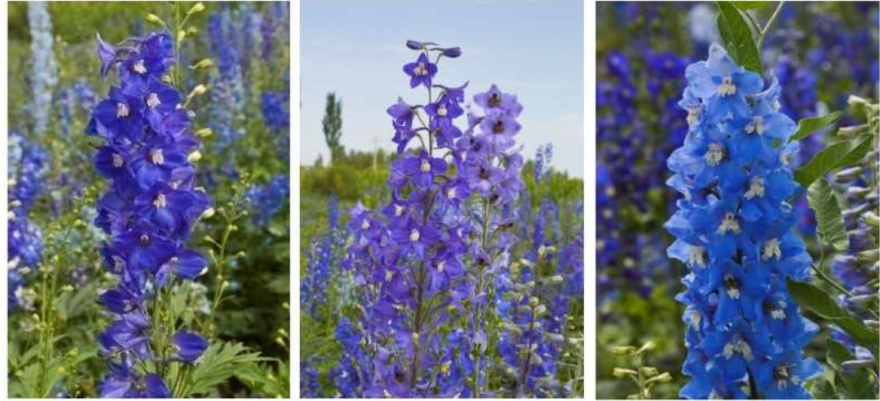
Figure 7. Diverse Delphinium ajacis (photos provided by Mr. Liming Zhao, Jiuquan, Gansu Province,